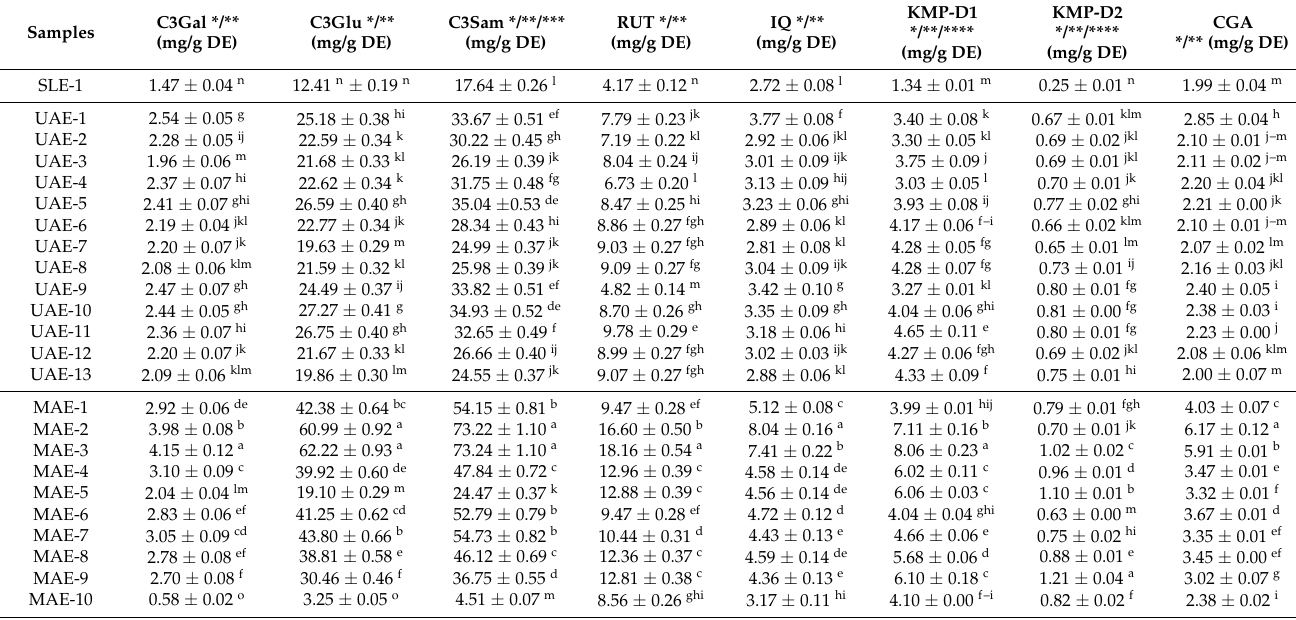
Table 3. Contents of phenolic compounds in black elderberry press-cake extracts determined by